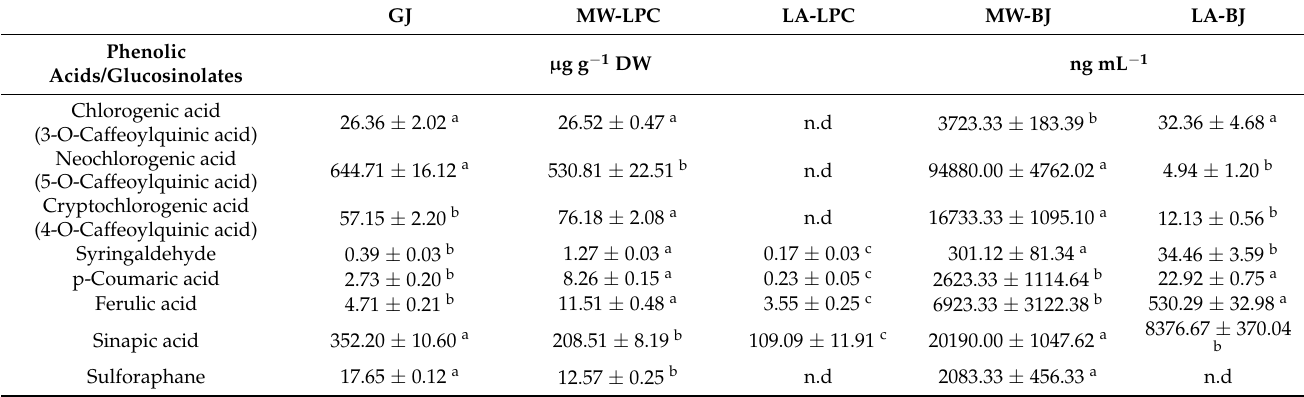
Table 5. Quantitative changes of phenolic acids/glucosinolates in broccoli green leaves-derived products by different processes ( Process 1; Process2 and Process 3 ): freeze-dried green juice (GJ); leaf protein concentrate obtained by microwave coagulation (MW-LPC); leaf protein concentrate obtained by lactic acid fermentation (LA-LPC); brown juice obtained by microwave coagulation (MW-BJ); and brown juice obtained by lacto-fermentation (LA-BJ). GJ MW-LPC LA-LPC MW-BJ